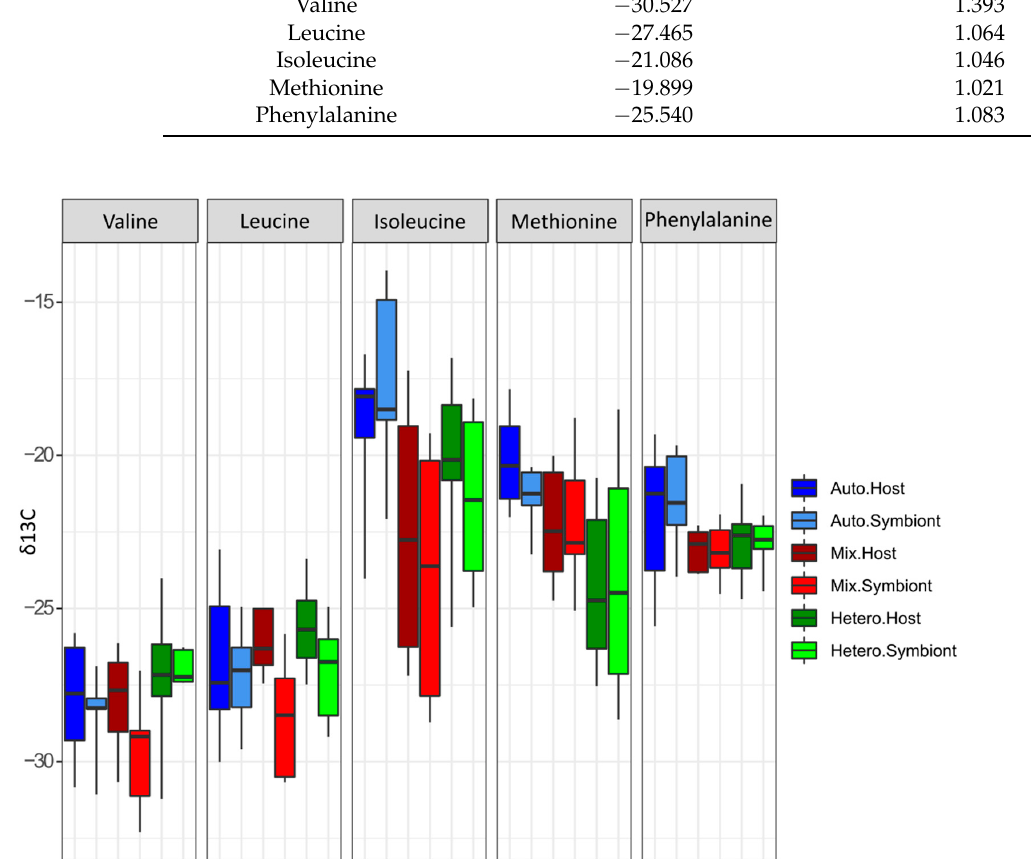
Figure 4. Changes in the δ 13 C value of the essential amino acids according to the nutritional state of the coral holobiont: the autotrophic host and symbionts are represented in blue, the mixotrophic host and symbionts in red and the heterotrophic host and symbionts in green. Table 2. The results from the statistical analysis testing the difference in δ 13 C value of the essential